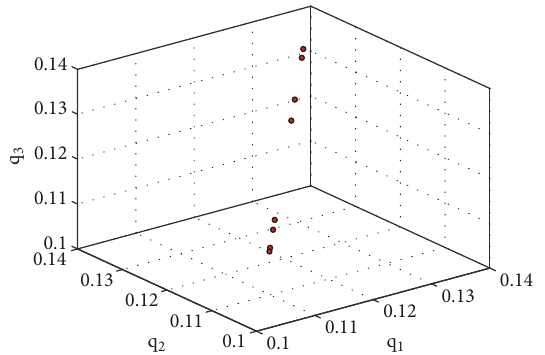
Figure 9: Phase portrait of the period 8-cycle of system (20) at (𝑎,𝑐,𝑘,𝛼,𝑞 , 𝑞 ,𝑞 , 𝑞 ) = (0.7,0.11, 18.26, 0.19, 0.15, 0.13, 0.11) 0,1 0,2 0,3 4